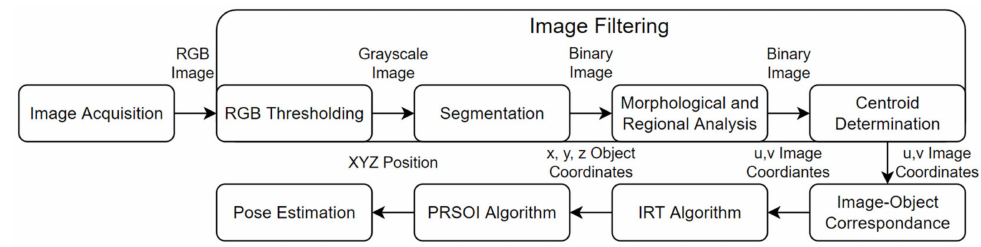
Figure 3. Image processing